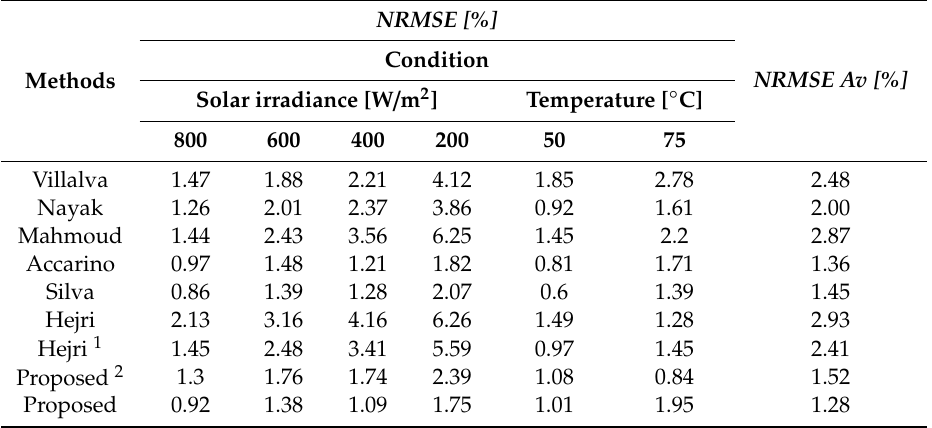
1 Curve fitting method. 2 Datasheet table value.